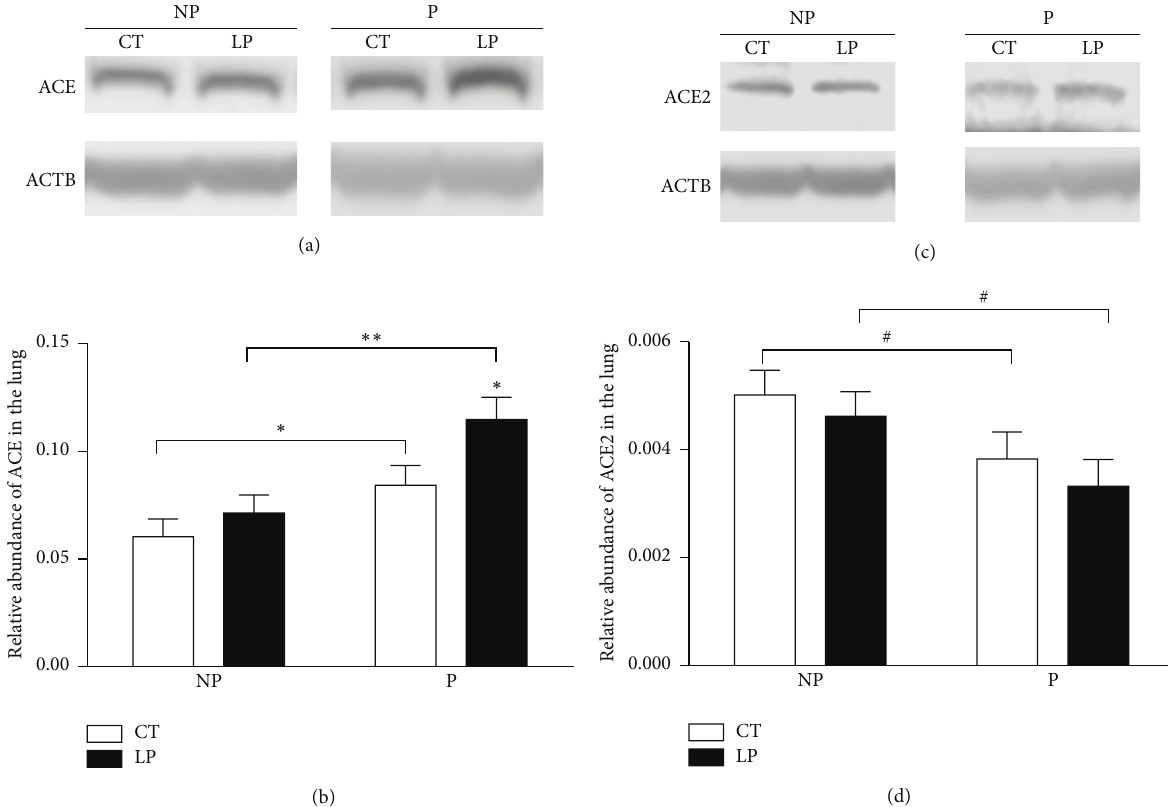
Figure 8: Western blotting analysis of ACE and ACE2 proteins in the lung of nonpregnant and pregnant rats fed a low-protein diet for 17 days. (a) ACE proteins shown as 150 kDa bands. (b) Relative abundance of ACE protein. (c) ACE2 proteins shown as 90 kDa bands. (d) Relative abundance of ACE2 protein. ACTB: beta-actin; CT: control; LP: low protein; NP: nonpregnant rats fed either CT or LP diet for 17 days; P: pregnant rats fed either CT or LP diet for 17 days. The error bar represents the mean ± SEM expressed as the ratio of density of the ACE or ACE2 band to that of ACTB ( 𝑛 = 5 - 6 rats/diet group/day). 0.05 < # 𝑃 < 0.1 ; ∗ 𝑃 < 0.05 ; ∗∗ 𝑃 < 0.01